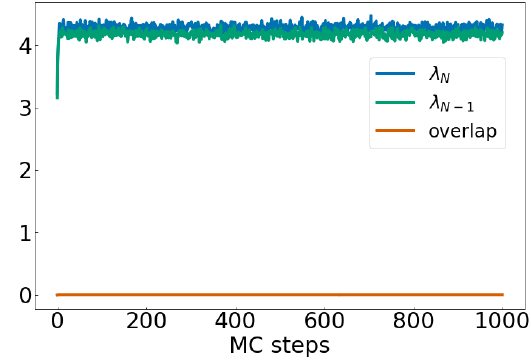
Figure 5: A run with two orthogonal replicas at temperature β 1 = β 2 = 4 for p = 2. We show the first two eigenvalues and the overlap between the two